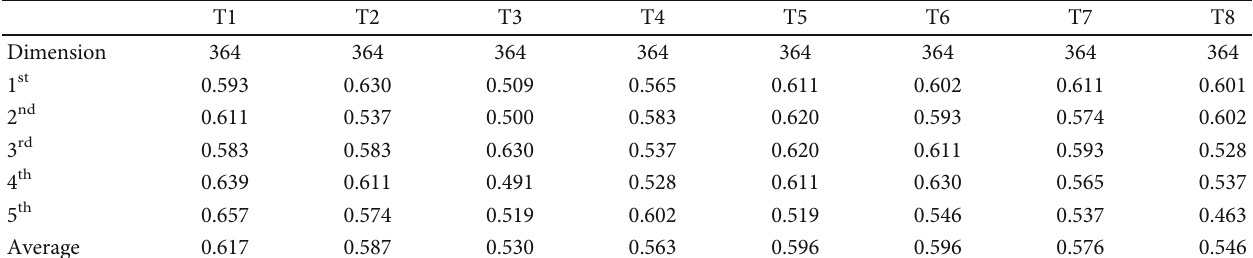
Table 2: Results of 5 times 10-fold cross validation of 8 trace features.